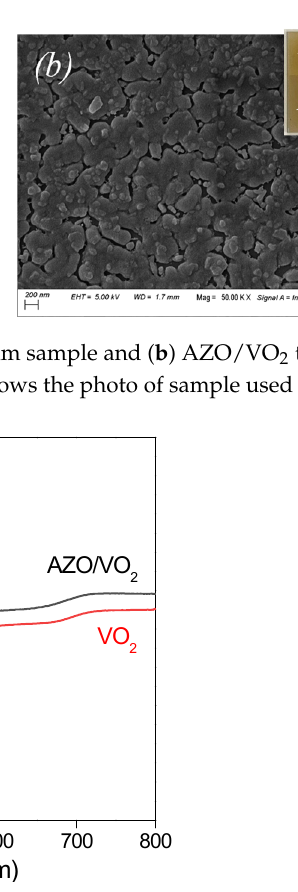
Figure 5. UV-Vis spectroscopy spectra of VO 2 and AZO/VO 2 thin film sample measured at room temperature.